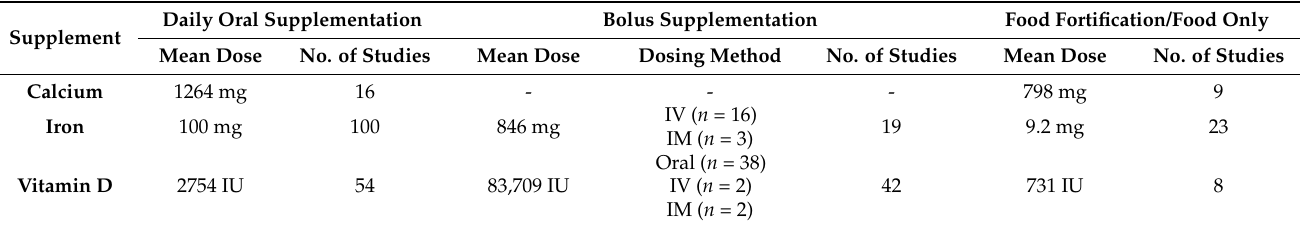
Table 1. Audited study supplements with method of delivery, dosage, and number of studies from which this information was